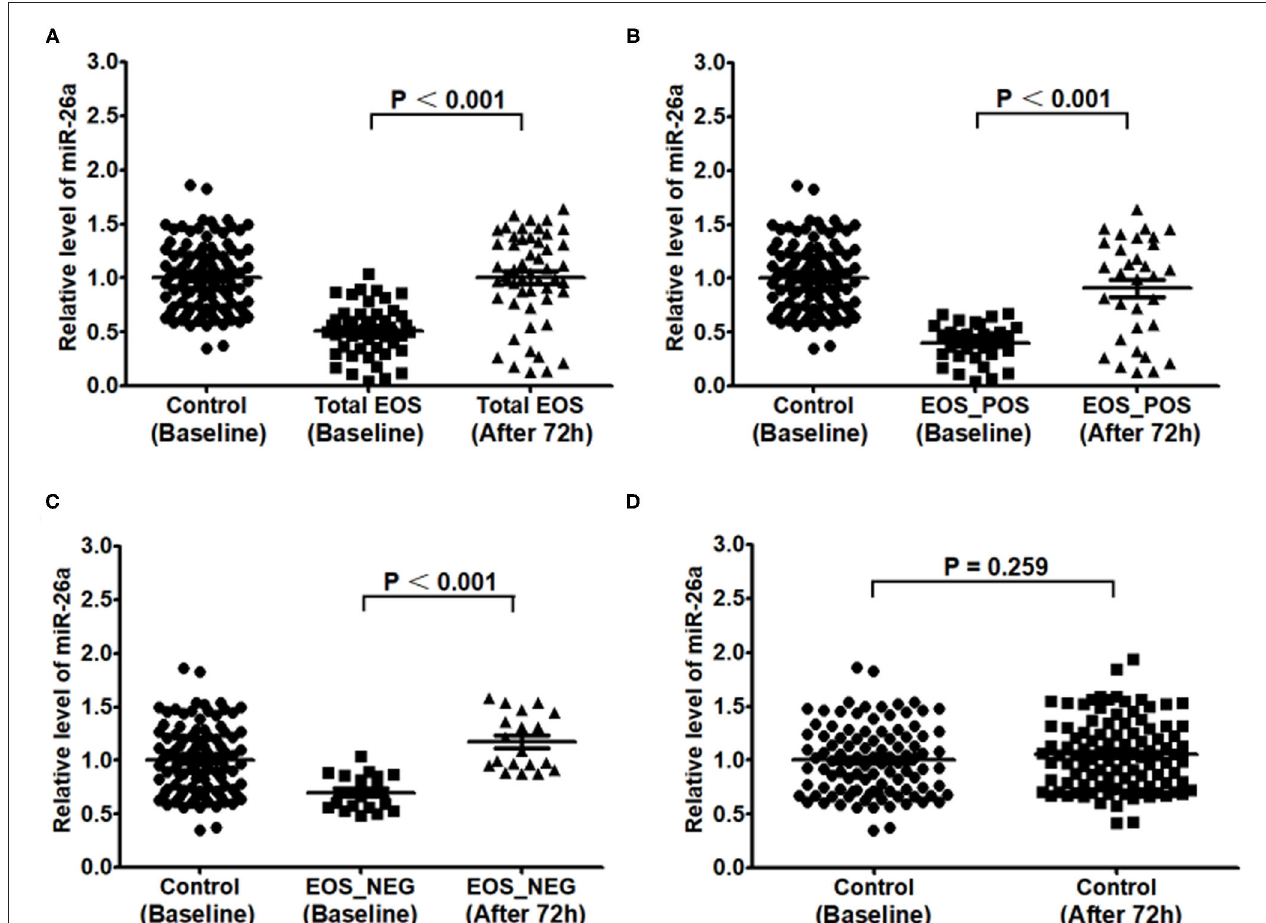
FIGURE 3 | Expression of miR-26a in peripheral blood mononuclear cells at baseline and at 72 hours after birth. In (A–D) , expression of miR-26a at baseline and after 72 hours was compared separately in the total EOS group, EOS_POS group, EOS_NEG group and control group. In the process, independent sample t -test was adopted, and “ P < 0.05” indicates a statistically significant difference. Total EOS, Newborns with clinical features of sepsis; EOS_POS, Newborns with positive hemoculture; EOS_NEG, Newborns with negative hemoculture.